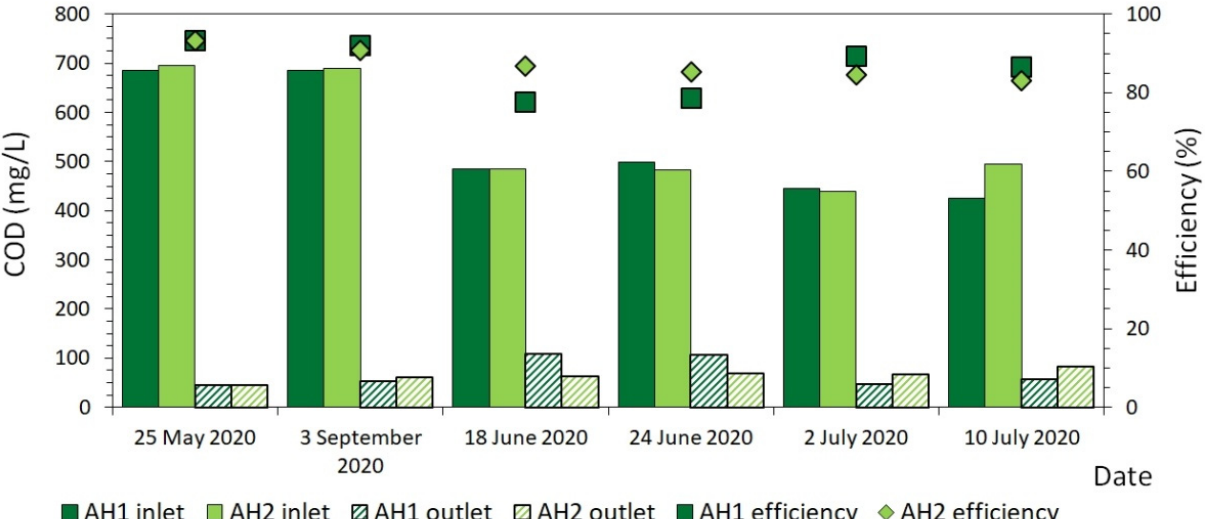
Figure 5. Inlet and outlet COD and removal efficiencies at stage II.